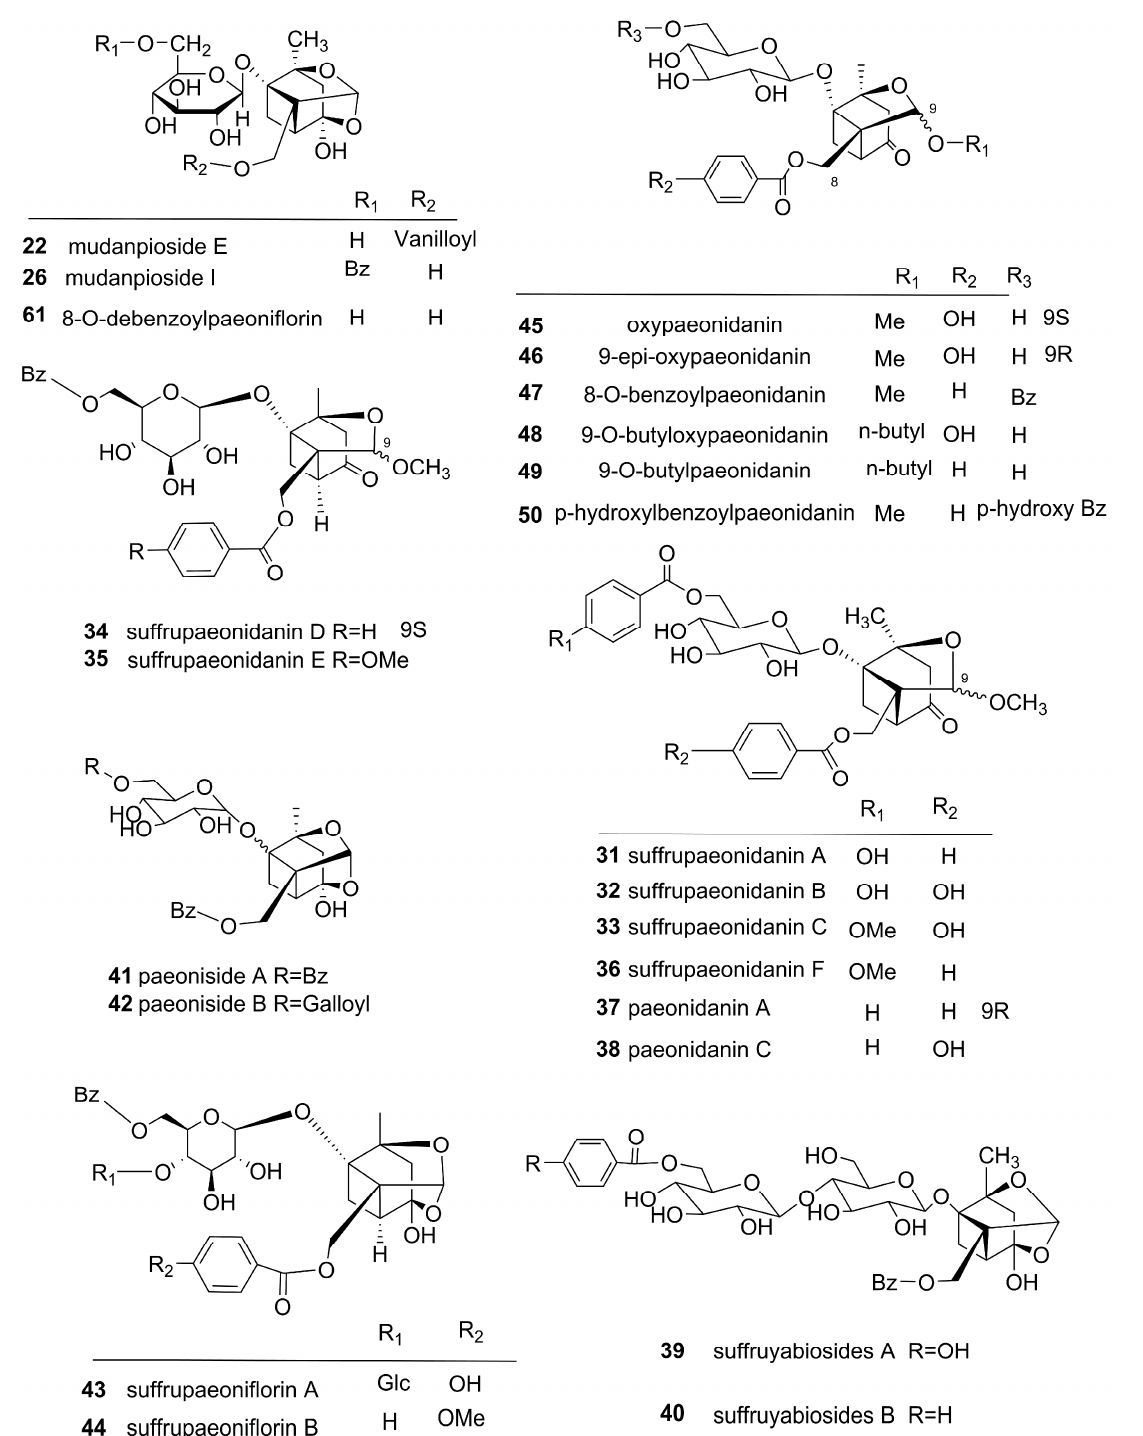
Figure 2. Cont. Figure 2.